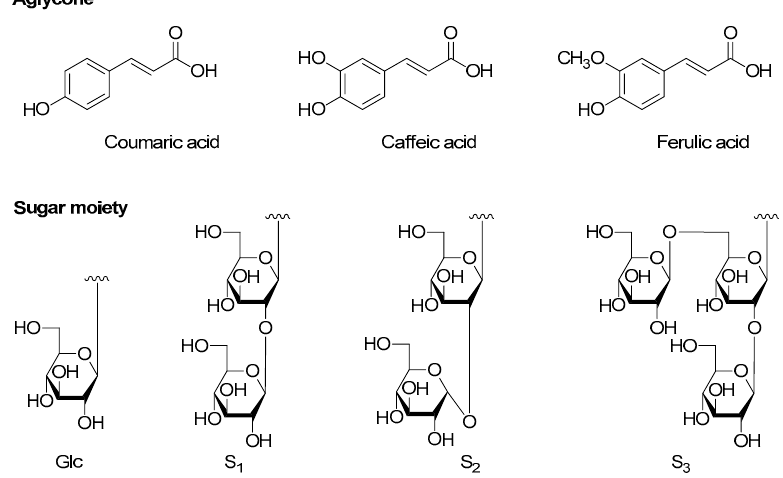
Figure 6. The structure of aglycones and glycosyls of phenolic acids from the aerial parts of A. mongolicum .